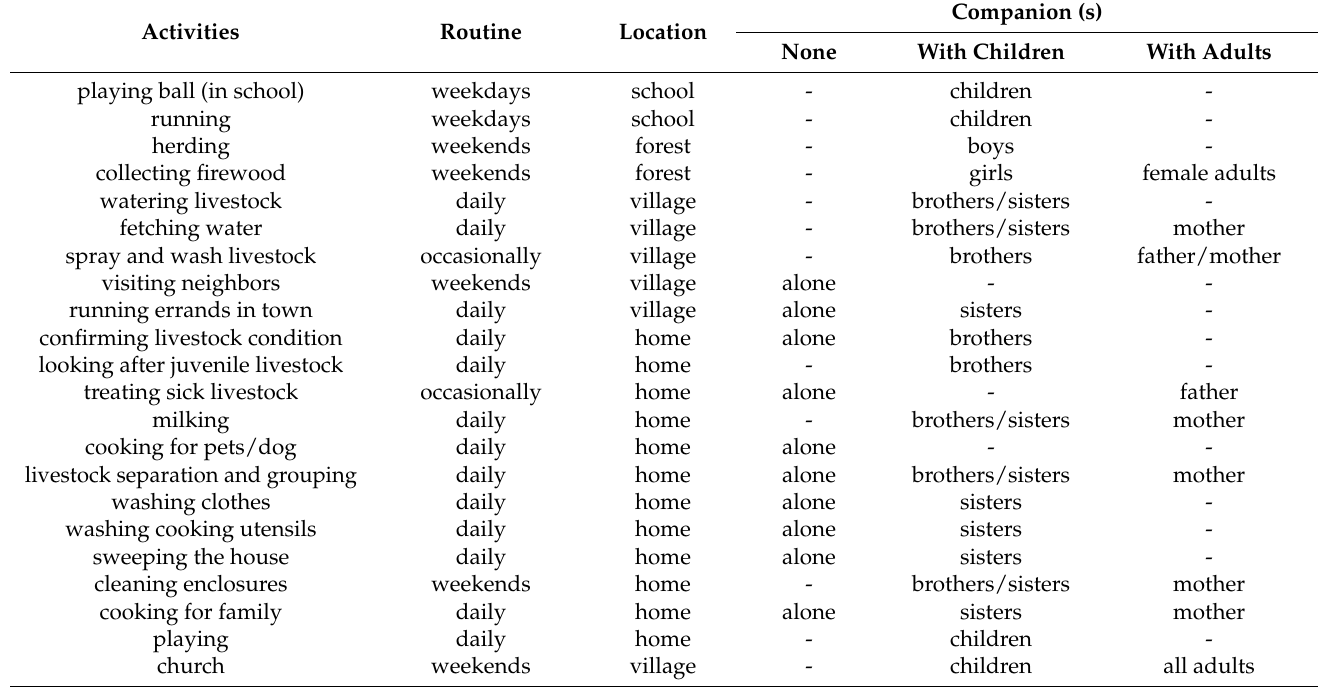
Table 1. Time, location, and companions for different